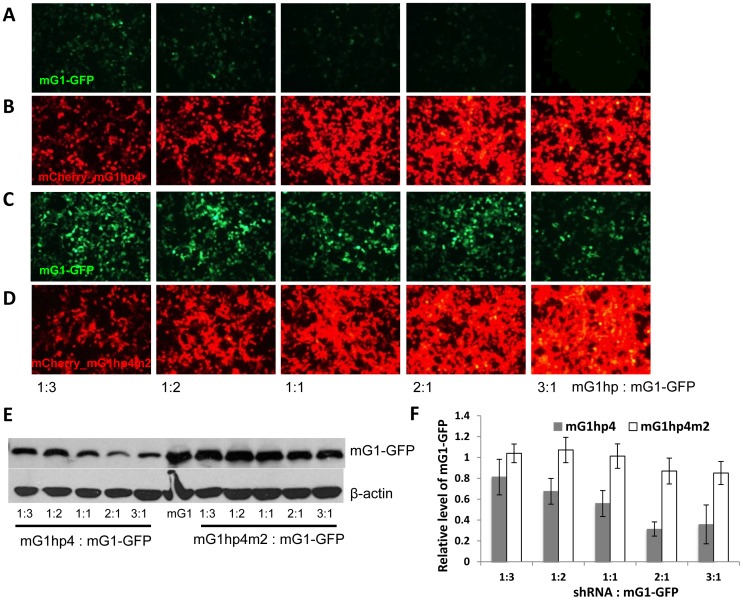
Dose-dependent and sequence-specific knockdown of mGCAP1 by mG1hp4. A–D.Fluorescence microscopy of HEK293 cells 48 hrs after cotransfection with mGCAP1-EGFP and mCherry_mG1hp4 (A, B) or its mismatched control mCherry_mG1hp4m2 (C, D) at five different mass ratios. GFP signal in row A is gradually diminished as mG1hp4 increases to a saturation level, indicating knockdown dose-dependency from 1∶3 to 2∶1. In row C there is no obvious change of GFP signal in cultures from 1∶3 to 2∶1 since the mutant mCherry_mG1hp4m2 is inactive for suppression of mGCAP1. Panels of rows B and D show increase in mCherry signal corresponding to increased mass ratios, left to right. E. Representative western blot evaluating mGCAP1-GFP protein levels in the cotransfected cells (50-hr post-transfection); mGCAP1-GFP was detected by anti-GCAP1 antibody, UW101, with β-actin immunostaining as the loading control. F. Quantification of relative mGCAP1-GFP levels shown in (E). The intensities of the mG1-GFP specific bands in western blot were measured by using ImageJ, and normalized against β-actin. The relative level of mG1-GFP in each cotransfected cell sample was averaged from three tests, representing the knockdown efficiency of each shRNA at different concentrations.